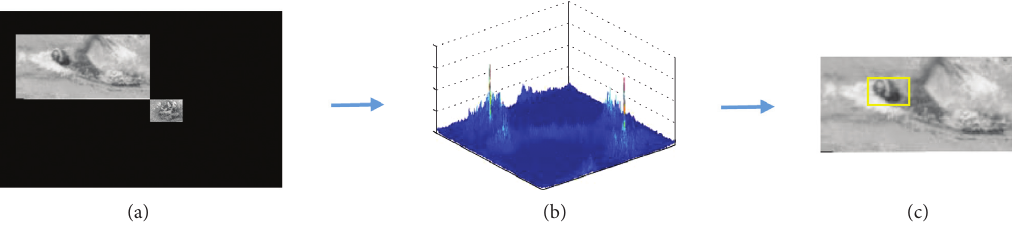
Figure 12: Application of NL-JTC technique for the detection of the swimmer’s head. (a) Input plane containing a Scaled Composite Reference and the region of interest provided by the a contrario localization process. (b) Correlation plane. (c) Detection and localization of the swimmer’s head. Swimming Championships in Limoges, France, April 2015.